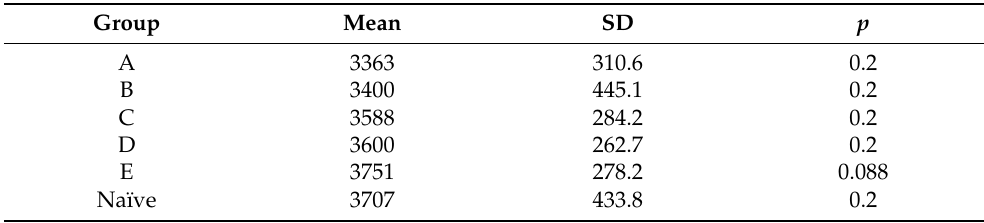
Table 2. Analysis of regulatory T cells by flow cytometry. Results of the statistical analysis of the flow cytometry experiment for each group are summarized in this table. Abbreviations used: SD—standard